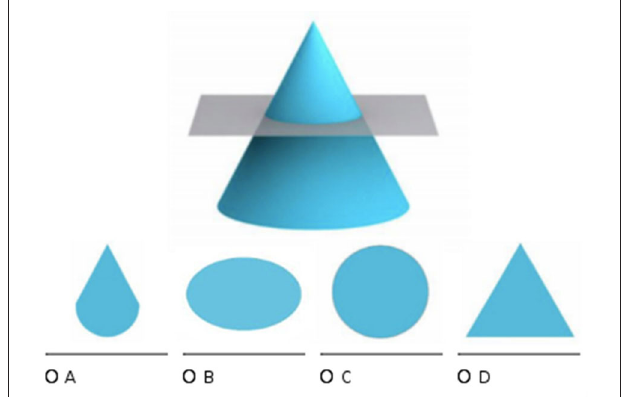
FIGURE 1 | A puzzle from the digital version of the SBST (Cohen and Hegarty,